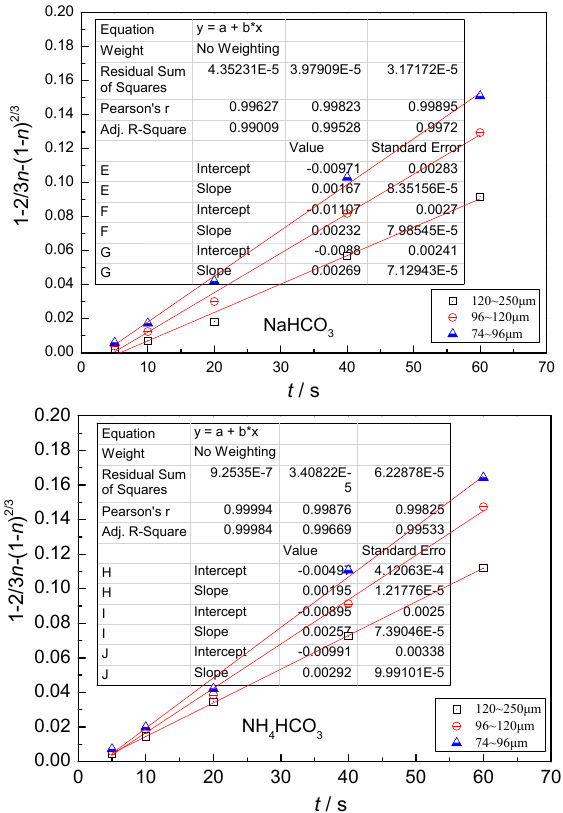
Figure 13. The linear relation between the reaction time and 1 − 2/3 η − (1 − η ) 2/3 (1 mol/L, 60 °C, 90 rpm). According to the kinetic equation, the reciprocal of the average particle size 1/ r is proportional to the synthesis reaction rate constant K 1 , which is shown in Equation